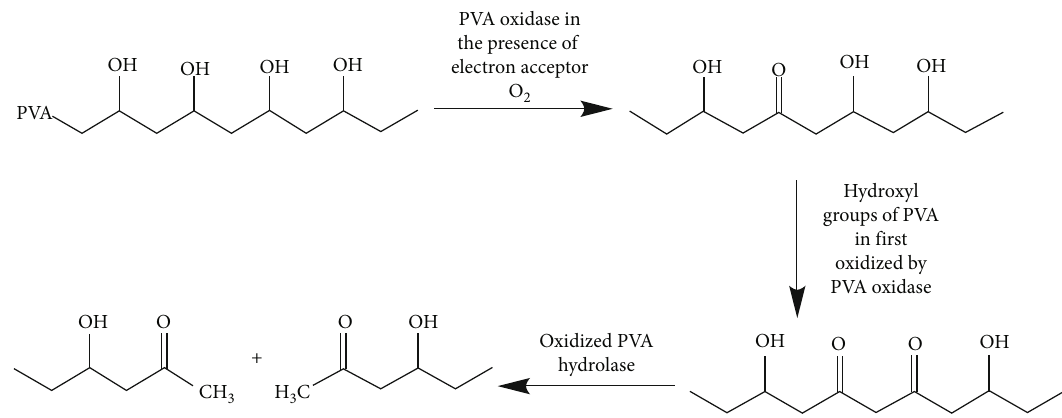
Figure 62: Possible pathway of PVA degradation.